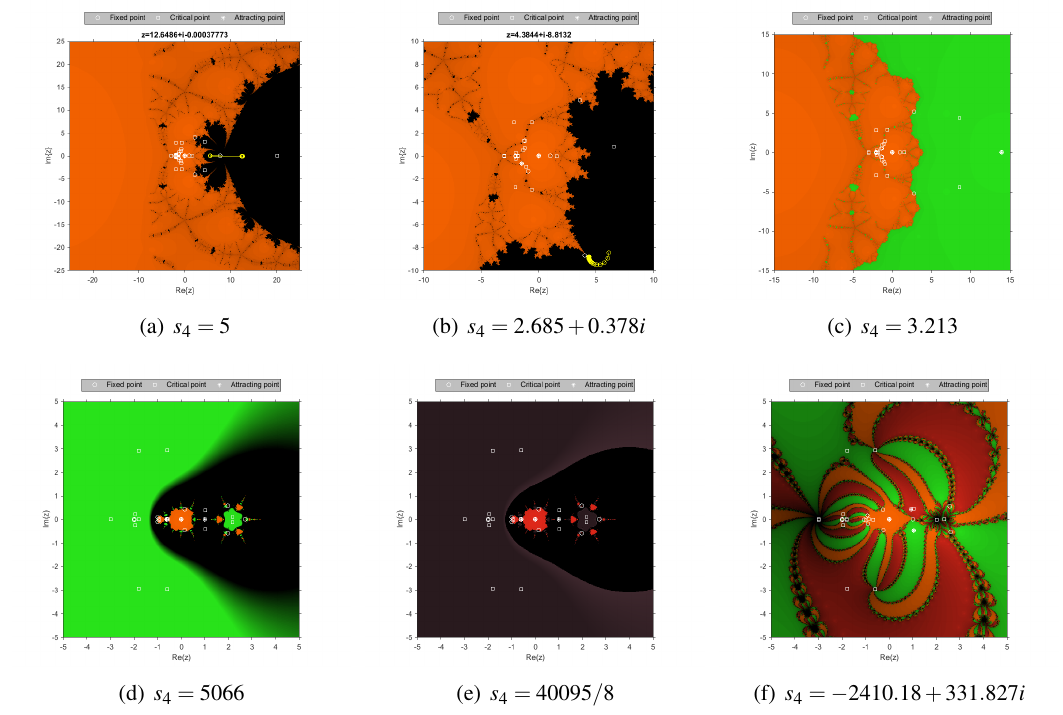
Fig. 7 Dynamical planes with unstable